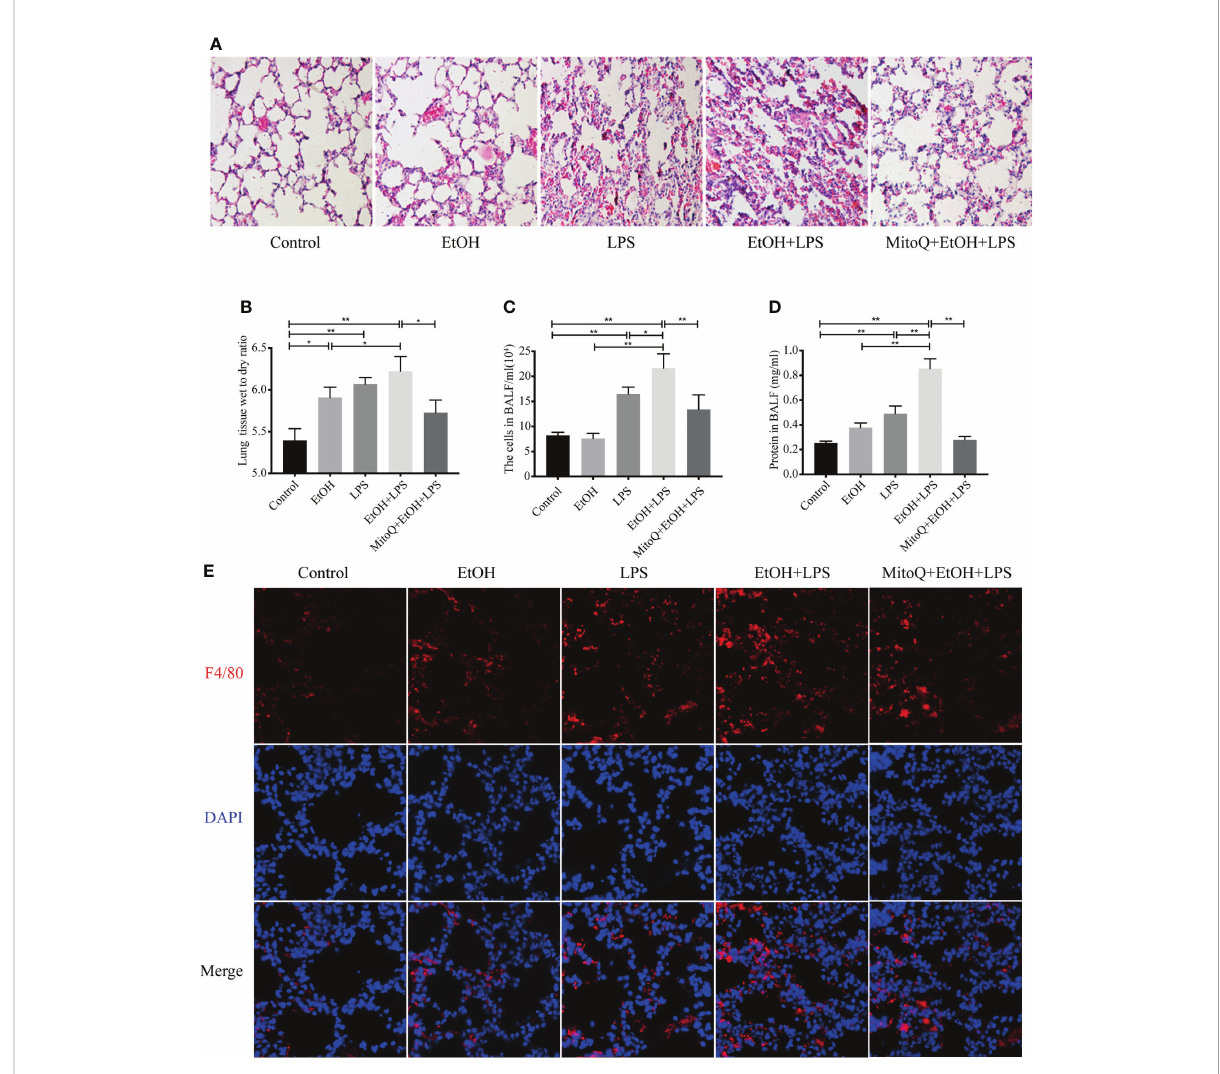
FIGURE 1 MitoQ alleviated lung injury induced by ethanol and LPS. C57BL/6 mice were pretreated with or without gradient alcohol feeding 5 weeks before LPS (5 mg/kg) inhaled for 6 h. Intraperitoneal injection MitoQ (10 mg/kg) twice a week at beginning of ethanol. (A) Representative histological section of the lungs was stained with hematoxylin and eosin (H&E staining magni fi cation 200×). (B) The left lung tissues were weighed before and after being dried at 60 °C for 72 h. The W/D ratio was then calculated. (C) The BALF was collected to measure the number of total cells. (D) The supernatant of BALF was collected and used BCA to measure protein content. (E) Immunostaining of F4/80 (red) was analyzed in lung tissues (magni fi cation 400×). All data were presented as mean ± SEM (n=6 in each group), *P < 0.05, **P <